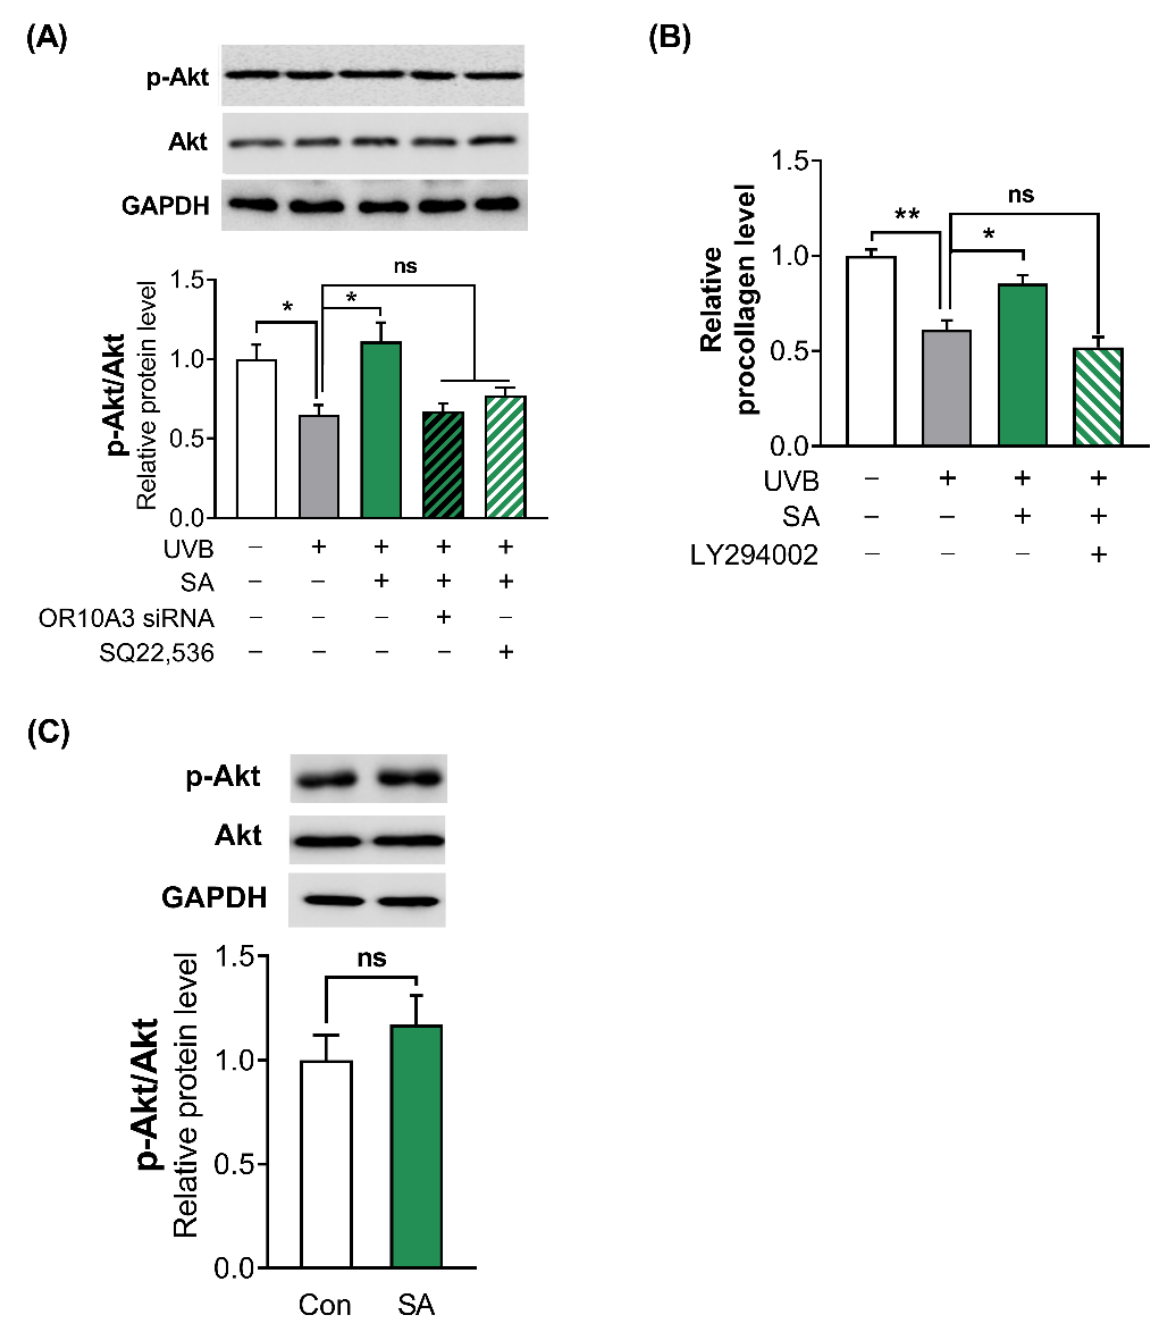
Figure 6. Suberic acid increased collagen production in UVB-exposed Hs68 cells through the Akt- dependent signaling pathway. Hs68 cells were treated with suberic acid or the vehicle after being exposed to UVB. ( A ) The OR10A3 siRNA or SQ22,536 (50 uM) was pre-treated for 1 h before the suberic acid treatment (SA; 100 uM). Then, Akt phosphorylation was analyzed. ( B ) The LY294002 (50 uM) was pre-treated for 1 h before the suberic acid treatment. Procollagen contents in the supernatant were analyzed. ( C ) Suberic acid-mediated Akt phosphorylation was analyzed without UVB exposure. Glyceraldehyde-3-phosphate dehydrogenase (GAPDH) was used as an internal control. Data are presented as mean ± SEM of three independent experiments. Statistically significant differences are marked as * p < 0.05, ** p < 0.01; ns, not significant.